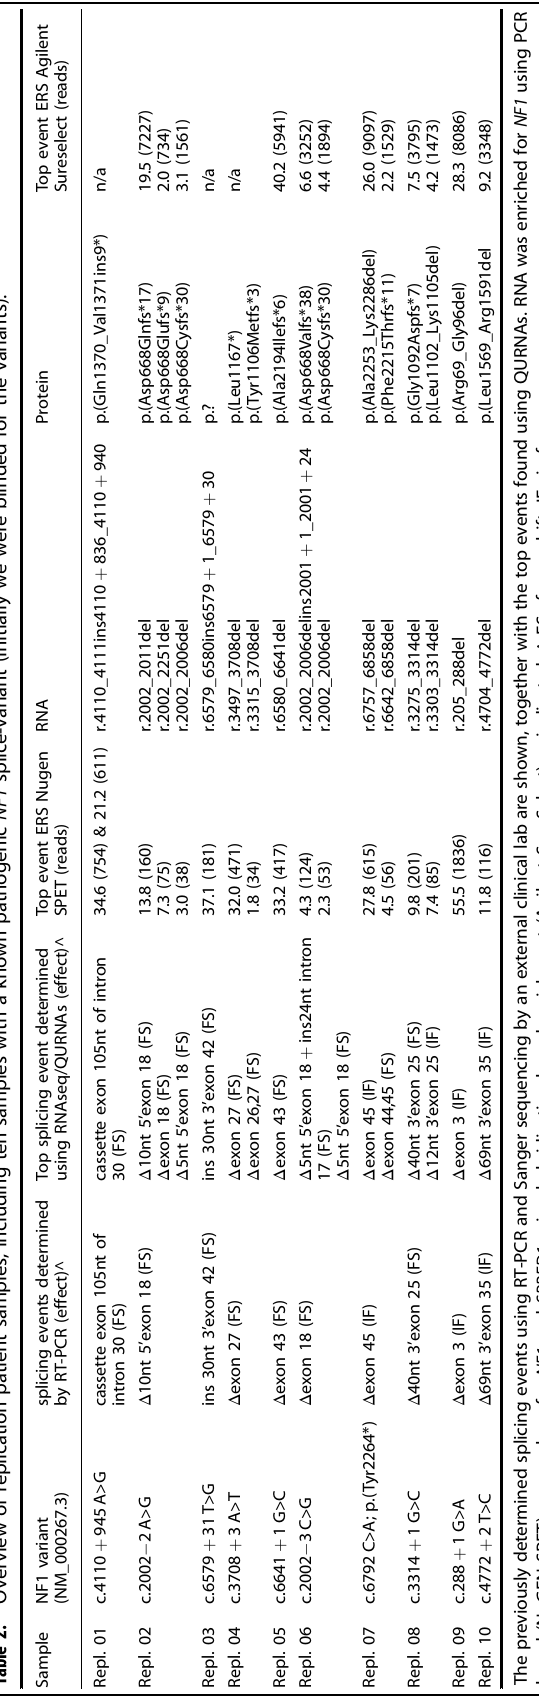
Part of the replication cohort samples was used to test the performance of QURNAs in combination with a different library preparation method to enrich for NF1 transcripts. PCR based targeting (NuGEN SPET) to enrich for NF1 was switched to a hybridization based enrichment (Agilent SureSelect). Comparable results were obtained with QURNAs using the different enrichment protocols. All splicing events were present using both methods with some variations in ERS and reads (Table 2 & Supplementary Fig. 5). Testing molecular undiagnosed cases with a (suspected) clinical diagnosis of NF1 Eleven patients with a (suspected) clinical diagnosis of NF1, who lacked a de fi nitive molecular diagnosis based on DNA diagnostics, were tested using targeted RNAseq (Sureselect, Agilent) and QURNAs data-analysis. All patients were checked for the highest ERS event(s) (Table 3 and Supplementary Data 4 and 5) and a possible drop in the relative expression of the normal exon junctions (Fig. 1b (patient Und-01), 2a (other patients)). When possible, heterozygous single nucleotide variants present in the coding DNA sequence were compared with the RNA sequence reads, to detect potential allelic imbalance (Table 3). For six patients no enriched pathogenic splicing event in NF1 nor SPRED1 (Supplementary Fig. 6 — only ERS for normal exon-junctions of SPRED1 ) could be detected based on high ERS, nor a prominent drop in ERS of the normal exon- exon junction(s). Also, comparing the DNA and RNA sequencing reads, no evident allelic imbalance was observed for these patients. Interestingly, for two patients we were able to identify a deep intronic pathogenic splice variant or and for three patients resolve the exact effect on RNA splicing for variants (VUS, likely pathogenic) previously detected using DNA diagnostics (Table 3). For undiagnosed patient 1 (in the same run as the replication samples), two major enriched splicing events between exons 38 and 39 were detected. These events introduce a cassette exon of 177 bp in intron 38 (acceptor site: ERS 51.3 and 1170 reads and donor site ERS 20.4 and 273 reads). In addition, a minor alternative acceptor site was also seen in the QURNAs output, resulting in a larger cassette exon of 208 bp at the 5 ’ end but having the same 3 ’ end (ERS 1.4 and 31 reads). The inclusion of these novel cassette exons, results in a drop in ERS of the normal 38 – 39 exon-exon junction (Figs. 1b, 2b). These aberrant splicing events are caused by a deep intronic c.5749 + 332 A > G change, that is visible in the RNAseq reads (Supplementary Fig. 7). The presence of this variant was con fi rmed with Sanger DNA sequencing as a de novo pathogenic splice variant by testing the patient and parents. This variant introduces a strong splice donor site at this position and consequently the activation of the above mentioned cryptic splice acceptor sites (Fig. 2b). Both aberrant transcripts contain a predicted premature stop codon and are consequently expected to result in loss-of-function through either nonsense-mediated mRNA decay (NMD), or an abnormal protein product (Fig. 2b). Comparing various hetero- zygous single nucleotide variants shows modest allelic imbalance in the RNA sequence versus DNA, which indicates some NMD (Supplementary Fig. 7). Of interest, the DNA variant is described multiple times and splicing was characterized by sequence analyses of cDNA clones with identical effect (both major and minor event) on RNA-splicing 33 , or similar effect on RNA-splicing (only major event) using direct cDNA sequencing 13,28 . T a